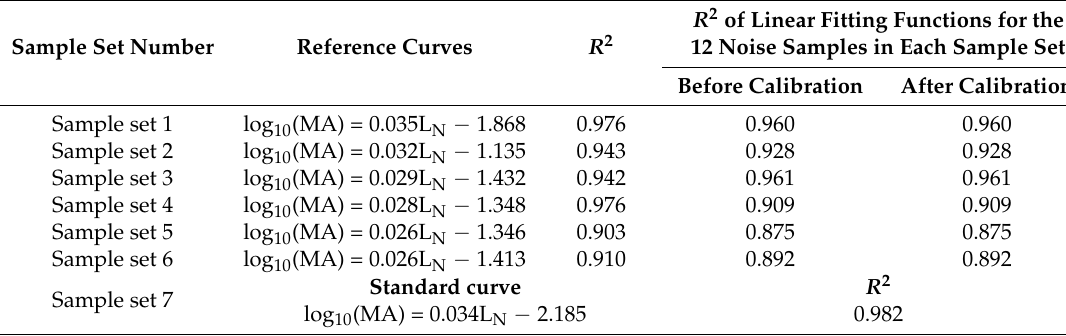
Table 3. Linear fitting results between L N and logarithmic MA in each sample